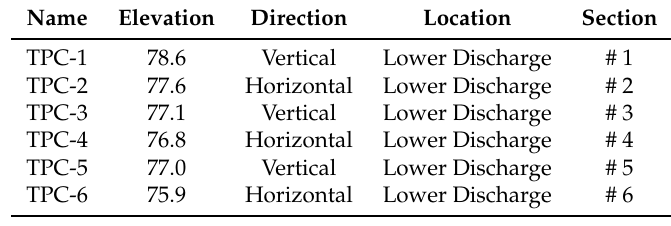
Table 4. Specifications of total pressure cells installed in Boostan Dam.